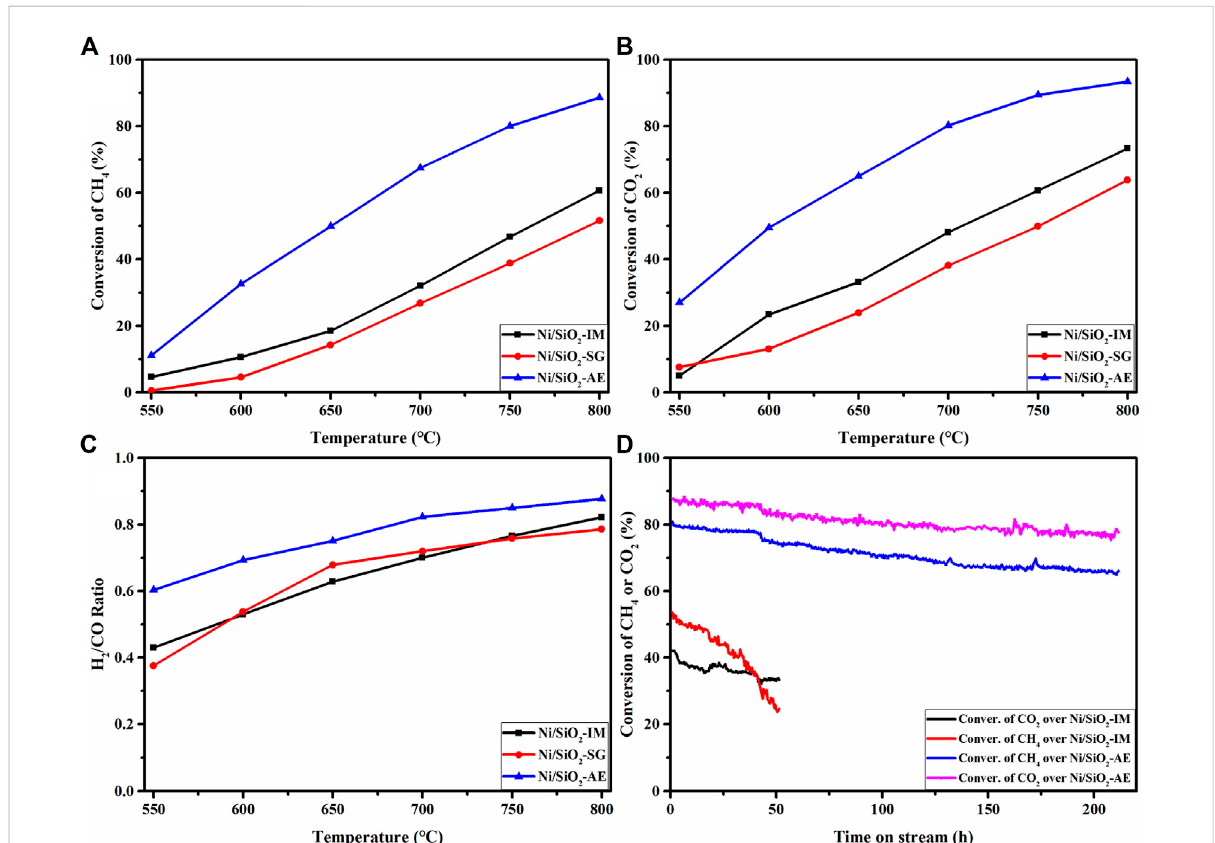
FIGURE 7 The catalytic performance of dry reforming of methane on Ni/SiO 2 catalysts prepared by different methods: CH 4 (A) , CO 2 (B) conversions and H 2 /COratio (C) overNi/SiO 2 catalysts. (D) ThecatalyticstabilityresultsofNi/SiO 2 -IMandNi/SiO 2 -AE.Reactionconditions: T =750 ° C,CH 4 /CO 2 =1:1, GHSV = 40,000 ml · (g -1 -cat h − 1